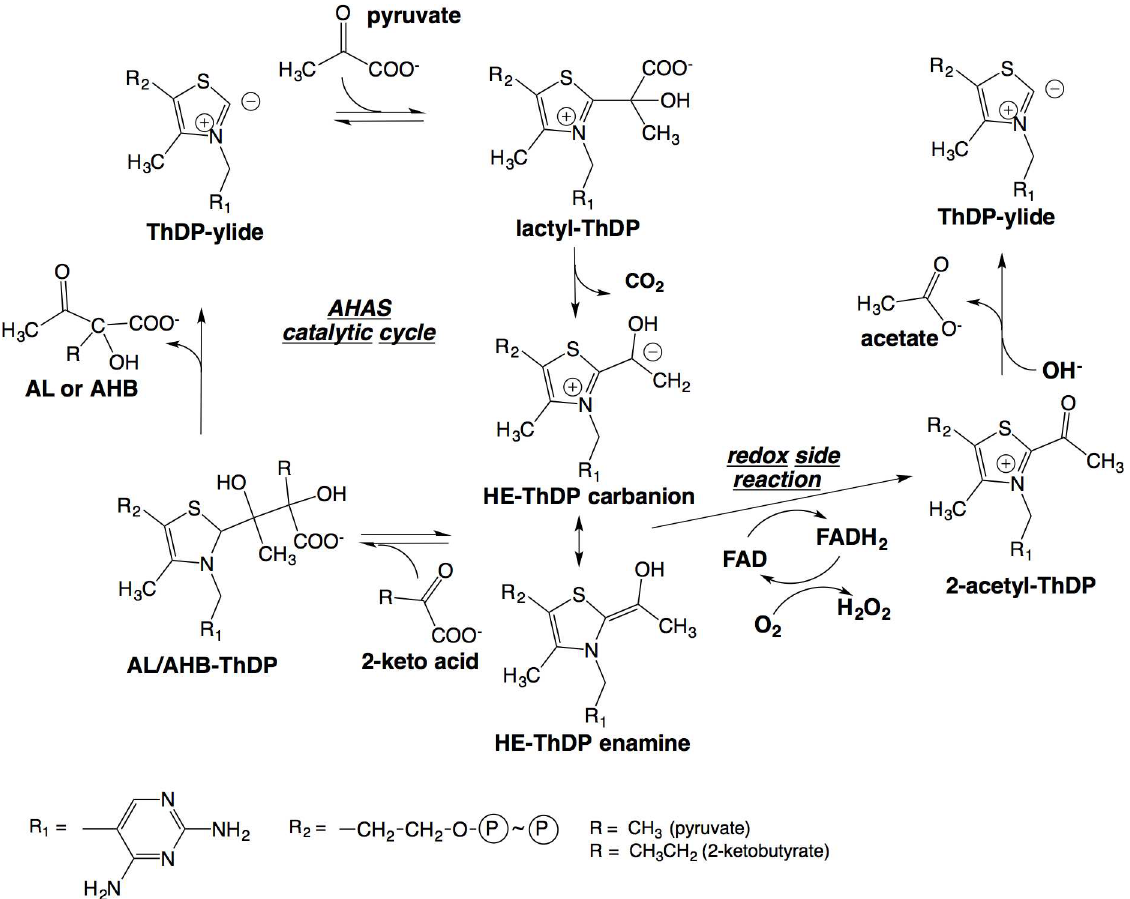
Fig 1. Catalytic cycle and redox side-reaction of AHAS with key intermediates. ThDP = thiamin diphosphate, HE = hydroxyethyl, AL = 2-acetolactate, AHB = 2-acetohydroxybutyrate.